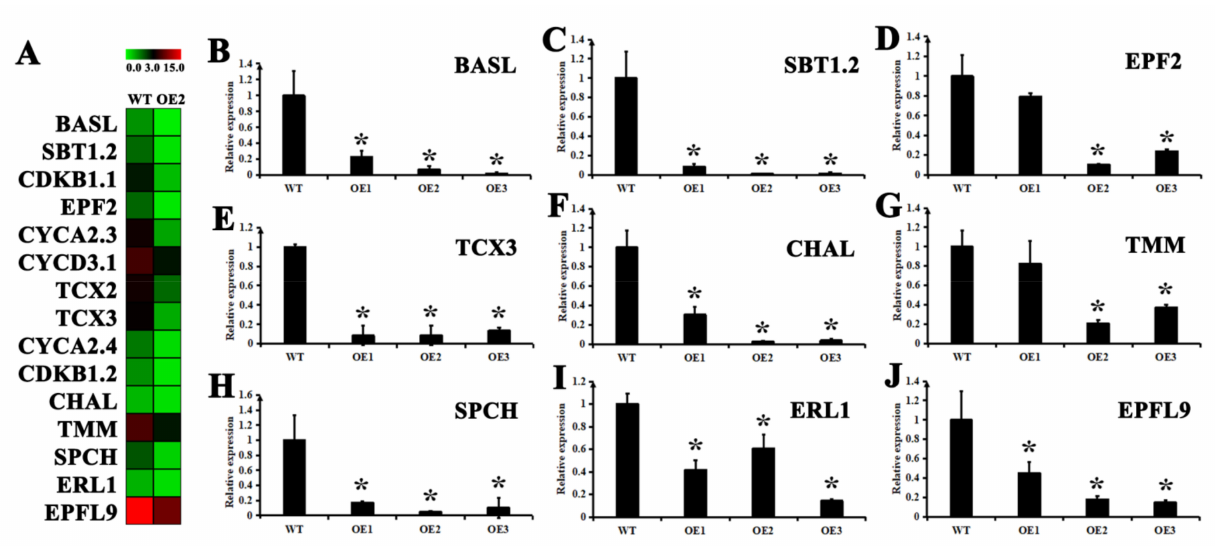
Figure 7. The landscape of CsSDG36 transcriptional regulation in Arabidopsis thaliana . ( A ) Hierarchical clustering analysis of genes in the categories ‘response to Stomatal development’. ( B – J ) Quantitative RT-PCR analysis of genes in the categories ‘response to Stomatal development’. Glyceraldehyde-3-phosphate dehydrogenase ( GAPDH ) was used as an internal control. Error bars indicate mean ± SD ( n = 3). * represents significant difference at p < 0.05 versus the wild type. The results were obtained from three biological experiments with three technical